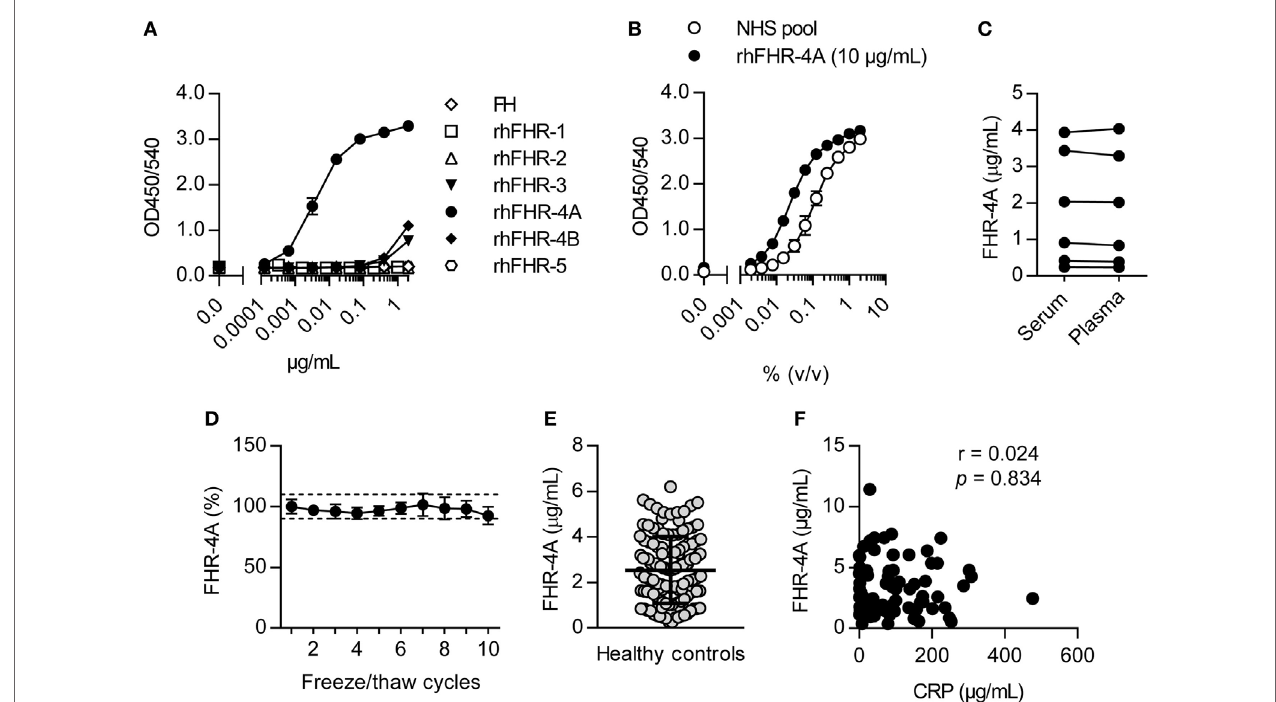
FigUre 4 | Development of the factor H-related (FHR)-4A specific ELISA. (a) Representative result on the reactivity of the FHR-4A ELISA against rhFHR proteins and plasma-derived FH. Anti-FHR-4A.04 was used as monospecific catching mAb, and binding of antigen was detected using cross-reactive polyclonal anti- FHR-3. (B) Calibration of pooled normal human serum using rhFHR-4A (10 µg/mL) in the FHR-4A ELISA. (c) Comparison of FHR-4A levels in seven paired serum and EDTA plasma samples using the FHR-4A ELISA. Each point represents the mean of three independent measurements per sample. (D) Effect of multiple freeze/ thaw cycles. Each point represents the mean of three independent measurements per sample with error bars indicating SD. Dashed lines indicate 90–110% range. (e) Concentration of FHR-4A in 129 healthy donor sera, measured by ELISA. Each point represents the mean of three independent measurements per serum sample. Line indicates mean with SD. (F) Scatter plot of FHR-4A levels versus CRP levels determined in 78 patients with acute bacterial infection. Correlation was assessed using Spearman’s correlation